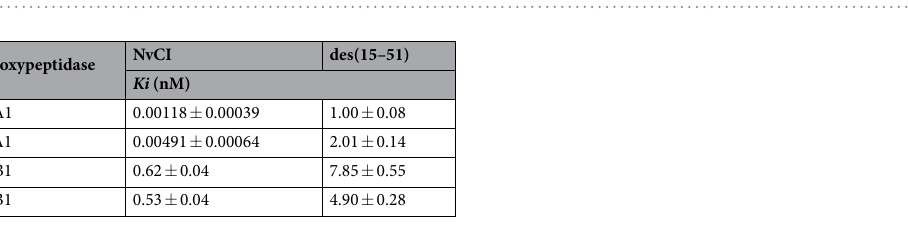
Figure 9. Disulfide scrambling of NvCI under different concentrations of denaturants. ( a ) The native form of NvCI was denatured in Tris-HCl buffer (pH 8.4) containing 0.25 mM 2-mercaptoethanol as thiol initiator and the indicated concentration of denaturants at 20 °C for 20 h. The denatured samples were quenched with 2% TFA and analyzed by RP-HPLC. The fractions a, b and c correspond to non-native (scrambled) isomers of NvCI. ( b ) Native fraction as a function of denaturant concentration. Denaturation of native NvCI is defined by the conversion of the native structure into scrambled isomers. The denaturants are Gdn.SCN ( ⚫ ), Gdn.HCl ( ○ ) and urea ( ▲ ).